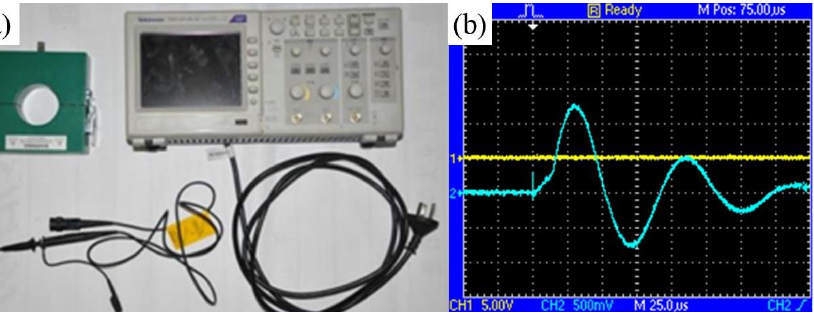
Figure 7. Finite element model of magnetic-pulse forming of pipe joint. ( a ) Oscilloscope and Roche coil; ( b ) Measured current curve (3kV).